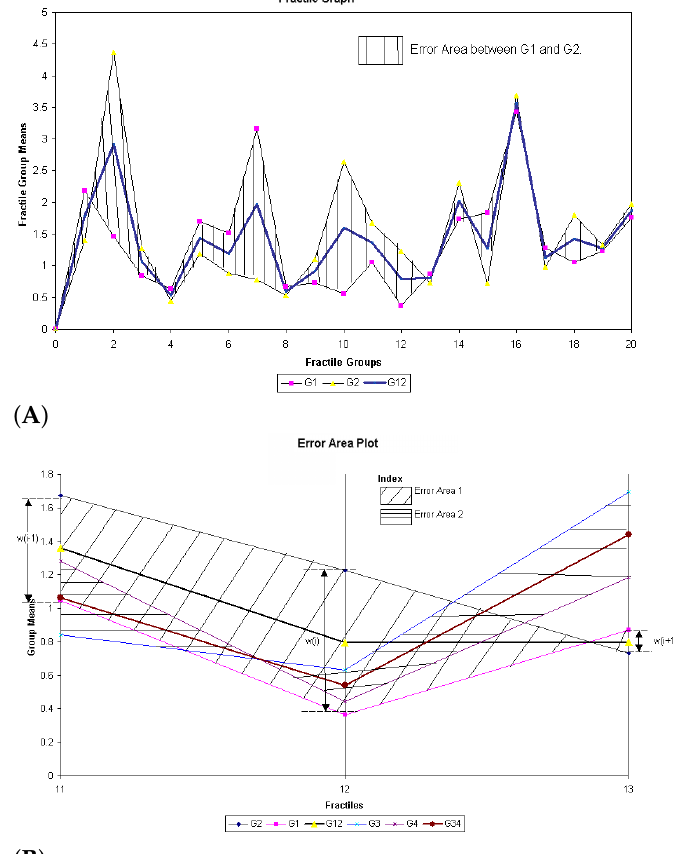
Figure 1A: Fractile Graphs give the individual and combined fractile group means from samples drawn from the same population. The error area between the graphs give an indication of the variation while the solid line G12 give the average estimate with 20 fractile groups.